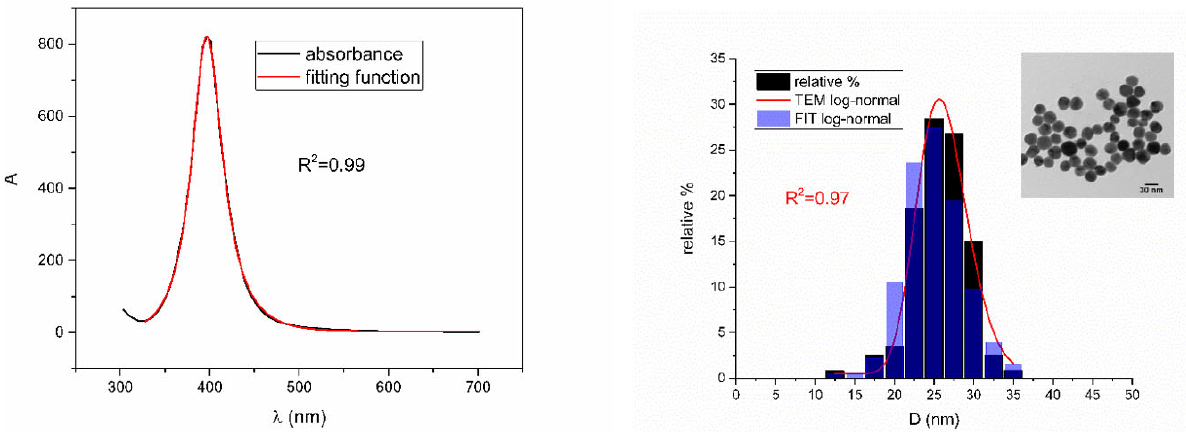
Figure 8. UV-Vis spectrum with fitting function ( left ) for sample EcoX_2. Reported and reconstructed size distributions are shown on the right . An additional TEM image is also shown.